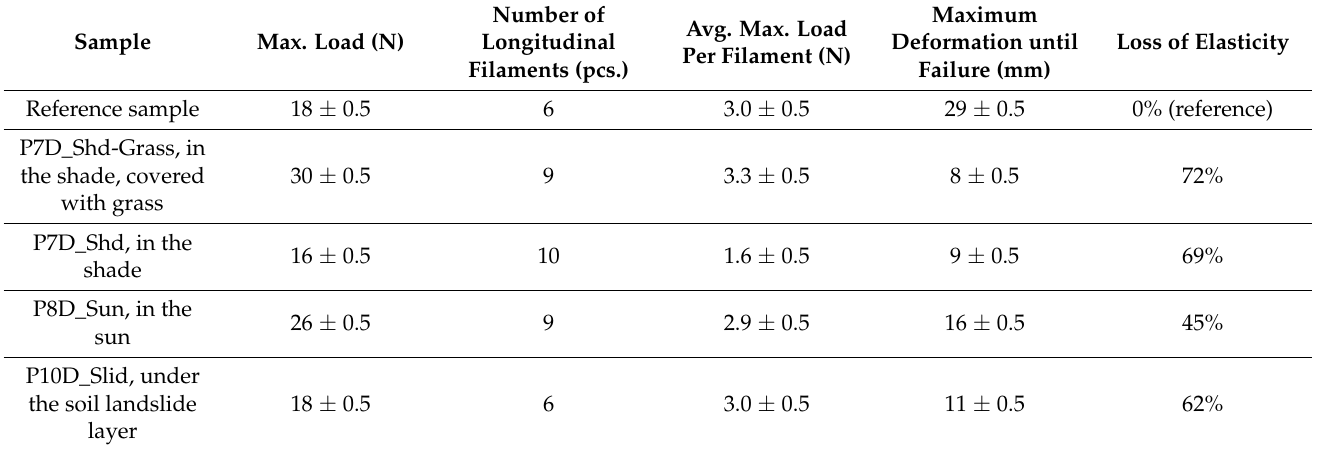
Table 3. Filament break test